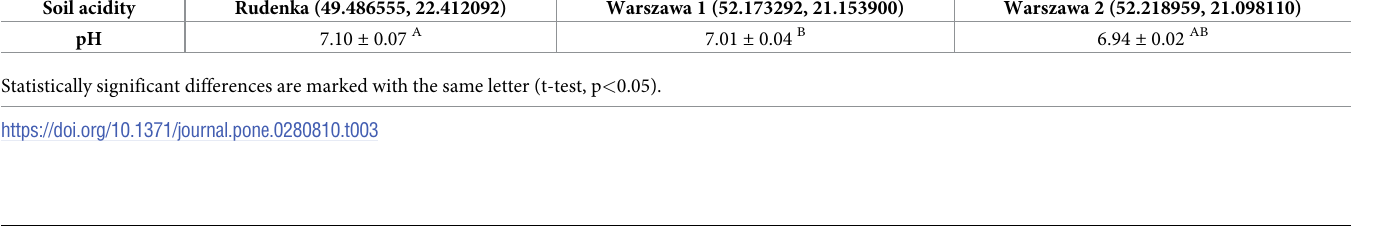
Table 3. The acidity (mean pH ± SD) of the soil surrounding the Taraxacum officinale roots. Soil